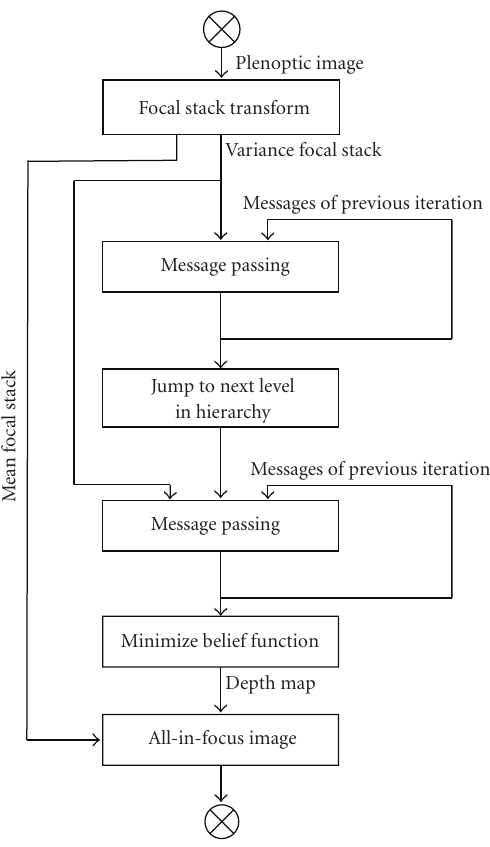
Figure 7: General flow of algorithm. Boxes represent kernel functions executing on the